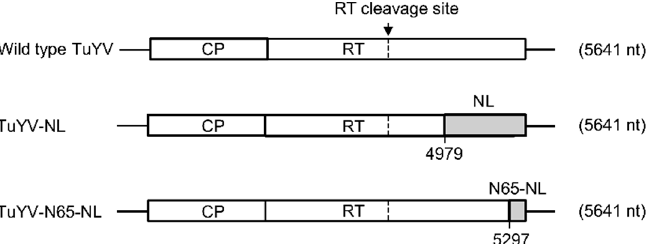
Figure 1. Schematic diagram showing insertion of the complete NanoLuc (NL) sequence or its N ‐ terminal domain (N65 ‐ NL) (grey boxes) into the 3 ′ part of the TuYV genome. The C ‐ terminal 171 (for NL) or 65 (for N65 ‐ NL) amino acids of the readthrough protein were replaced by NL or N65 ‐ NL sequence leading to TuYV ‐ NL and TuYV ‐ N65 ‐ NL mutants having the same genome size as wild ‐ type TuYV (5641 nt). White boxes represent open reading frames coding for coat protein (CP) and readthrough protein (RT). The black arrow indicates the RT cleavage site at amino acid 437 [20], giving rise to the truncated RT protein (RT*) that is incorporated in the capsid.